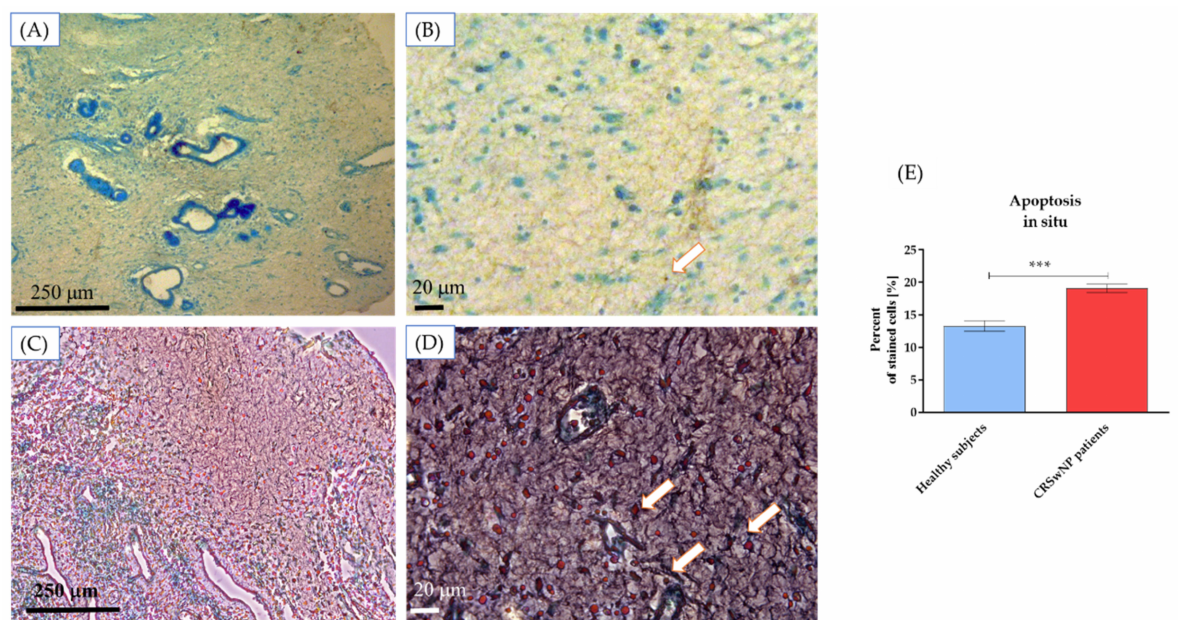
Figure 1. Apoptosis detection in tissue sections derived from healthy subjects ( A , B ) and CRSwNP patients ( C , D ). The statistical analysis was performed on representative images (healthy subjects n = 5 and CRNwNP n = 5). Scale bars, 250 and 20 µ m are indicated in the microphotographs. The white arrows indicate apoptotic nuclei. The statistical analysis results show significantly increased apoptotic cells in tissues of CRSwNP patients ( E ). Statistically significant differences were noted at p < 0.001 (***).